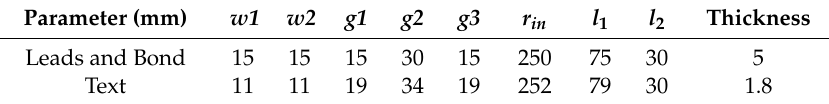
Table 1. Dimensional parameters of leads , bond, and text layers